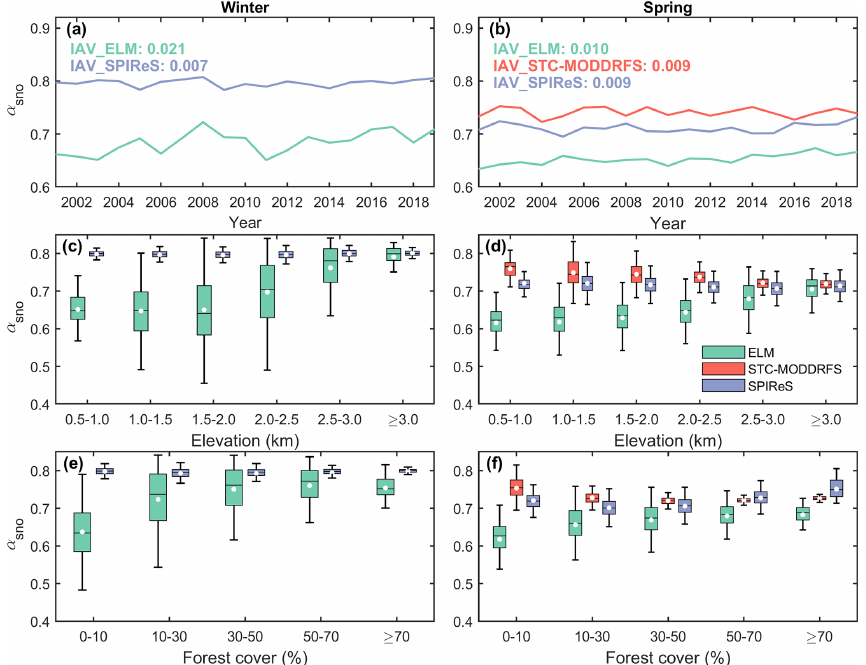
Figure 9. (a, b) Time series of regional average values, (c, d) elevation gradients, and (e, f) change with forest cover of snow albedo ( α sno ) in ELM (green), STC-MODSCAG (red), and SPIReS (blue) over the WUS. Panels (a, c, e) are for winter, and panels (b, d, f) are for spring. In panels (c) – (f) , the white dots represent the average